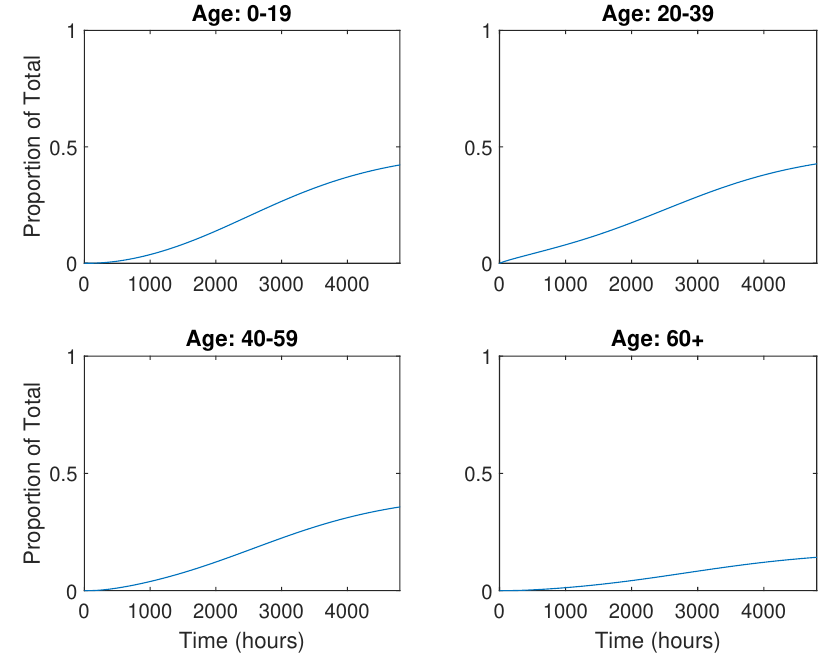
Figure 8. Total number of recovered by age group with UVGI filtration A = 45, q =